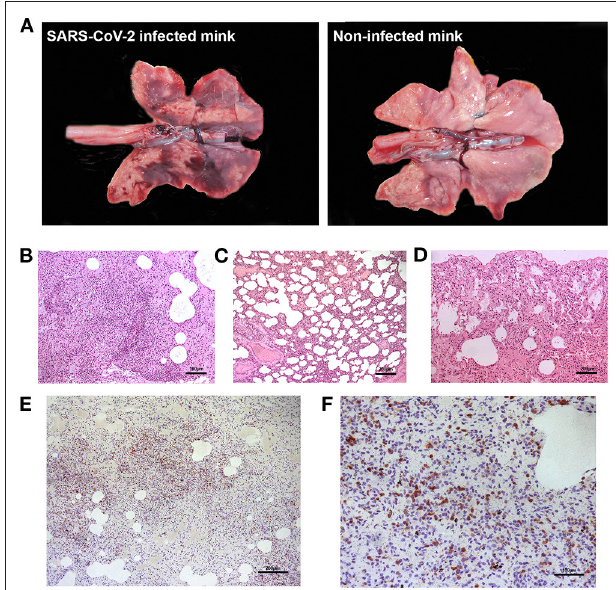
FIGURE 2 | Gross and microscopic pulmonary lesions in minks infected with SARS-CoV-2. (A) Gross lesions are characterized by irregular dark areas of consolidation in the lungs of infected minks (left). Right panel shows the lungs from a non-infected, healthy mink not presenting dark consolidated areas. (B) Perivascular inflammatory infiltrates and bronchointerstitial pneumonia with alveolitis are observed in one positive mink (H-E, x100). (C) Thickened alveolar walls by inflammatory infiltrates in one positive mink (H-E, x50). (D) Normal histological features in the lung of a mink negative for SARS-CoV-2. (E) Marked proliferation of T lymphocytes in the lung interstitium of one positive mink, confirmed by immunohistochemistry using an anti-CD3 antibody (x50). (F) Magnified capture of (E) showing immunopositive T lymphocytes